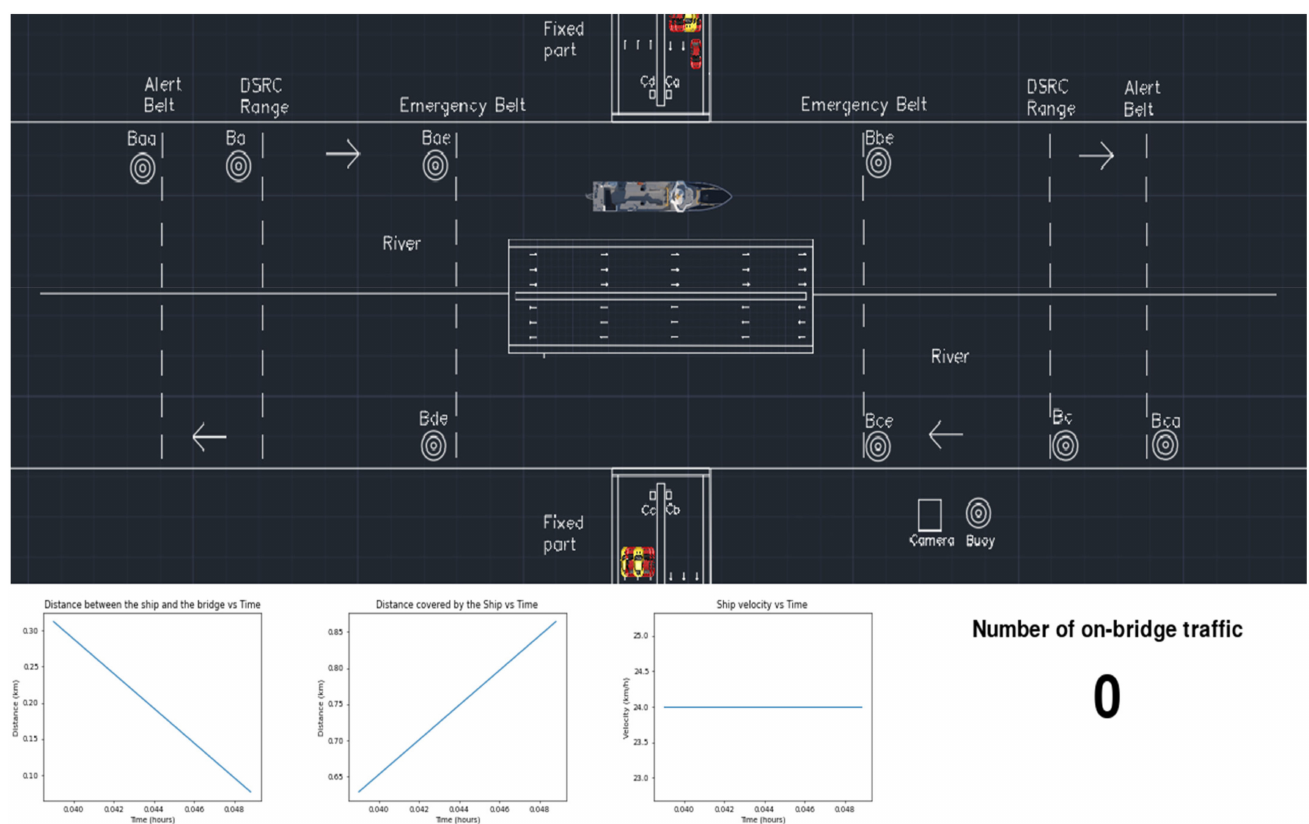
Figure 9. Automated bridge system and ship navigation at Fort Madison Swing